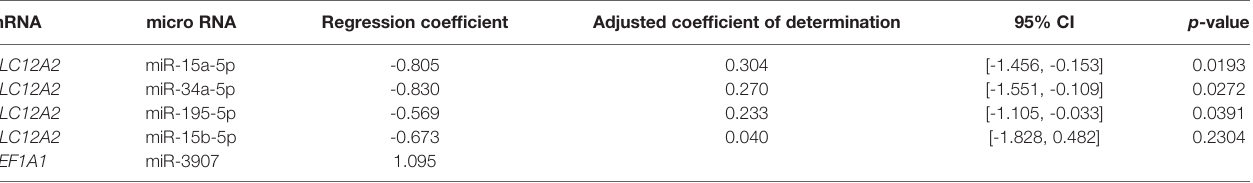
TABLE 2-A | Simple regression analysis between micro RNA and mRNA in conventional adenoma in validation cohort (cohort 2). mRNA micro RNA Regression coef fi